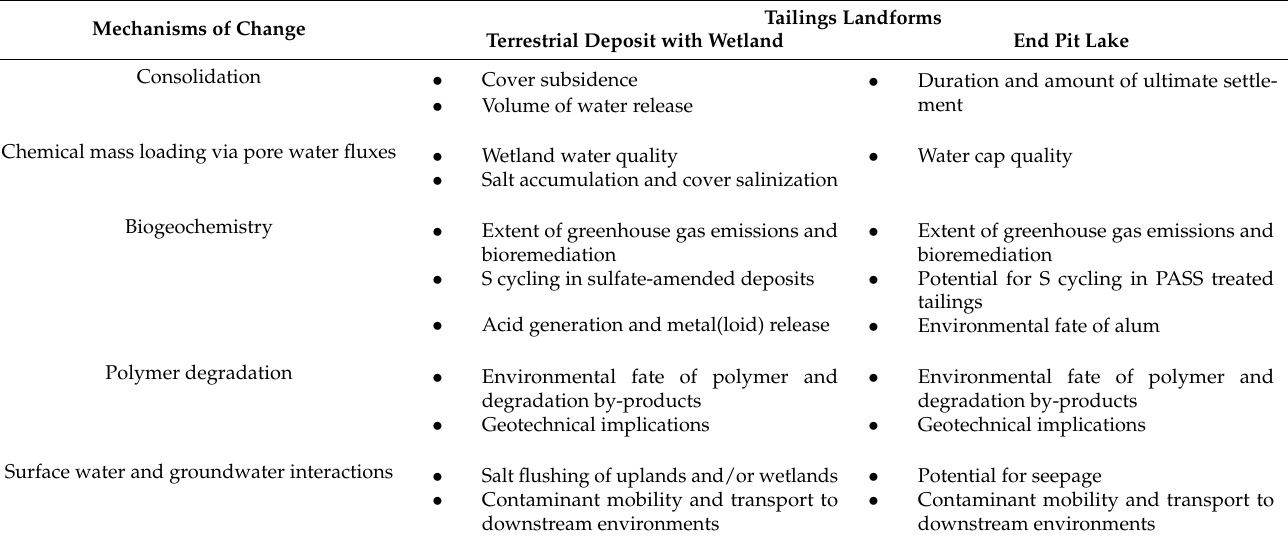
Table 5. Key considerations and knowledge gaps surrounding the geochemical stability of oil sands tailings landforms. Mechanisms of